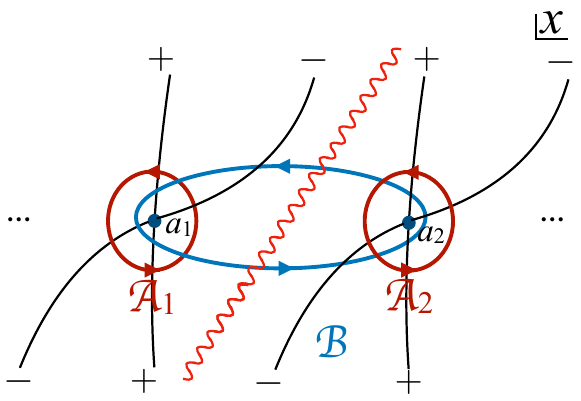
Figure 6 . The local degenerate Weber-type Stokes graph is depicted. We here consider two different A cycles for generality, but they are identical for our present system with periodic